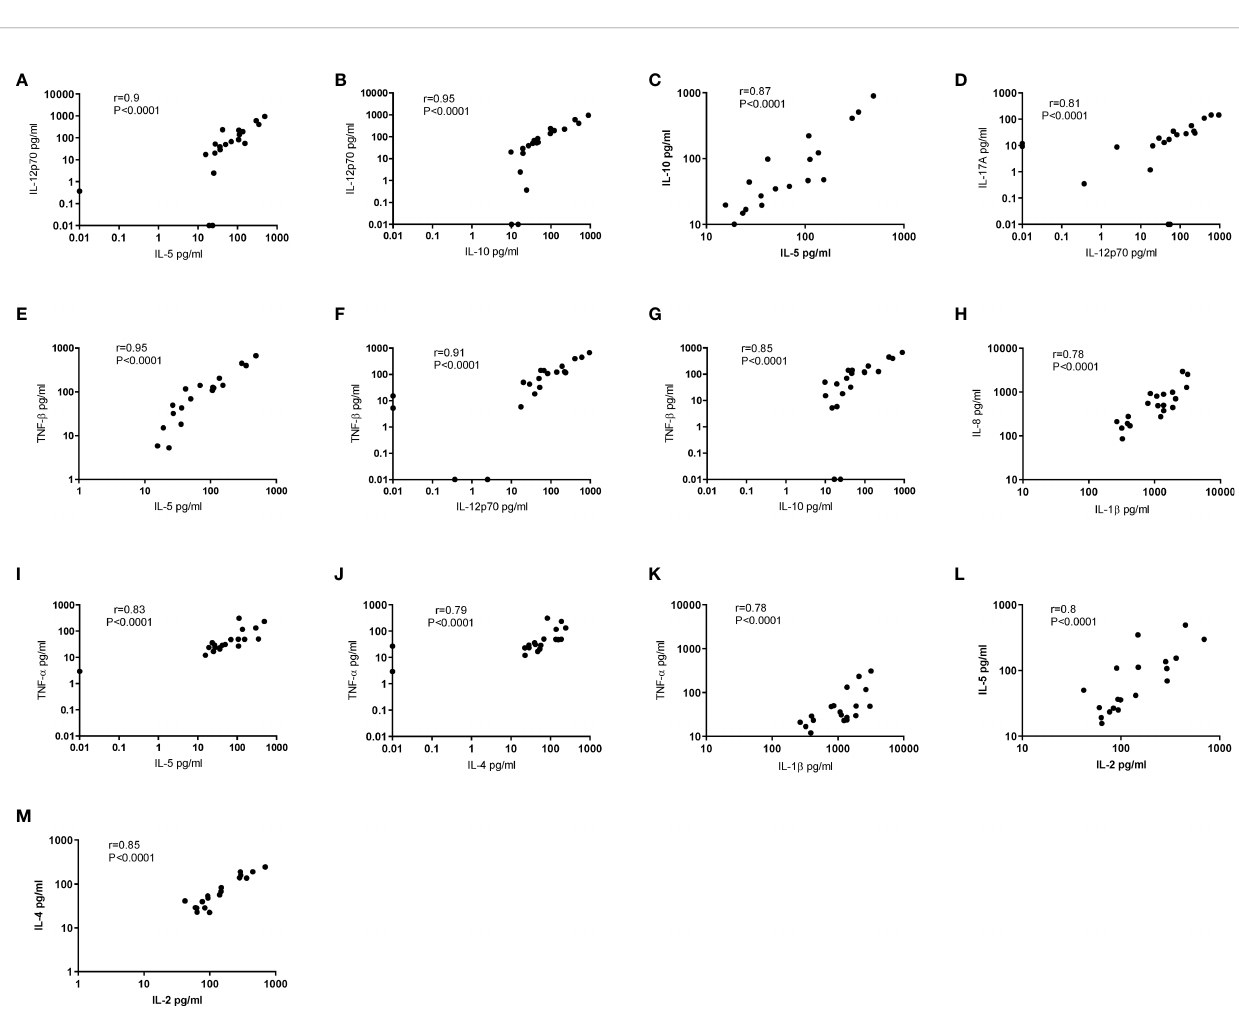
FIGURE 6 | Correlation coef fi cients between 12 cytokines in Saliva. Correlation of normalised salivary cytokine concentrations in BD saliva (N=20). Spearman correlation was determined, r and p values with 95% CI. (A) IL-12p70 vs IL-5, (B) IL-12p70 vs IL-10, (C) IL-10 vs IL-5, (D) IL-17A vs IL-12p70, (E) TNF- b vs IL-5, (F) TNF- b vs vs IL-12p70, (G) TNF- b vs IL-10, (H) IL-8 vs IL-1 b , (I) TNF- a vs IL-5, (J) TNF- a vs IL-4, (K) TNF- a vs IL-1 b , (L) IL-5 vs IL-2, (M) IL-4 vs IL-2.